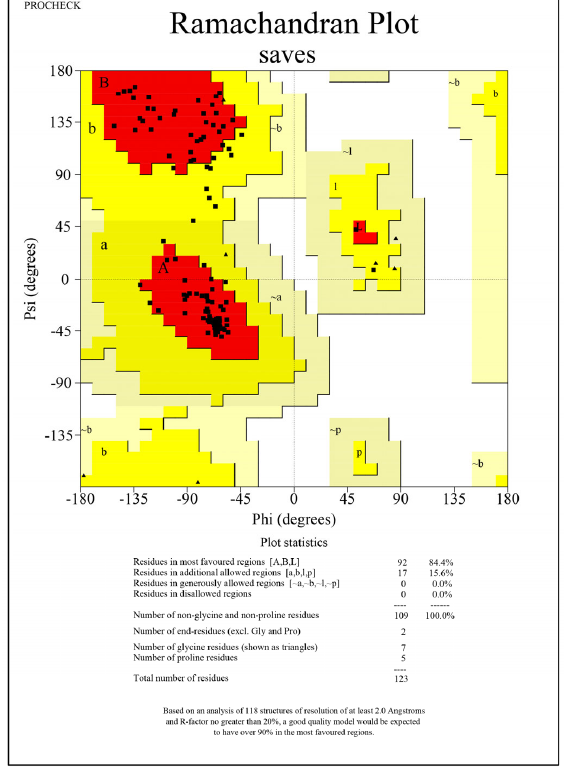
Figure 3. Ramachandran plot of virulent MPXVgp169 protein based on Phi and Psi angles; most favored regions (red), additional allowed regions (yellow), generously allowed regions (light brown) and disallowed regions (white).